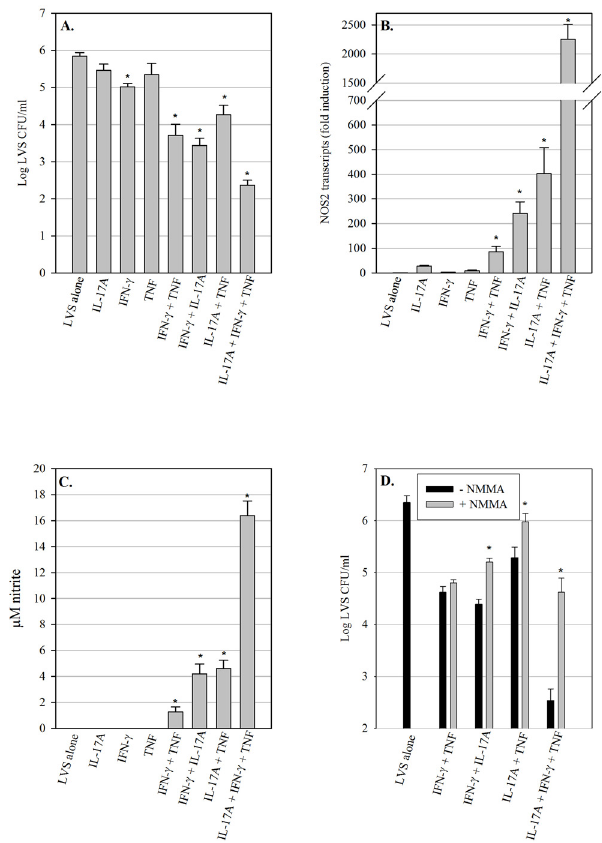
Fig 1. Cytokine-induced control of F . tularensis LVS growth in pulmonary epithelial cells is partially dependent upon RNI. (A) TC-1 lung epithelial cells were infected with LVS, and intracellular bacteria were enumerated after 72 h. Cultures were treated with recombinant cytokines immediately after infection as indicated, or untreated ( ‘ LVS alone ’ ). * = significantly different from ‘ LVS alone ’ cultures (P < 0.05). (B) Changes in expression of NOS2 in TC-1 cell cultures infected with LVS and treated with recombinant cytokines. Fold induction values are expressed relative to ‘ LVS alone ’ cultures. * = significantly different from cultures treated only with single cytokines (P < 0.05). (C) Nitrite production in TC-1 cell cultures infected with LVS and treated with recombinant cytokines after 72 h. * = significantly different from ‘ LVS alone ’ cultures (P < 0.05). (D) 72 h growth of LVS in cytokine-treated TC-1 cultures in the presence of NMMA. * = significantly different from LVS growth in identically treated cultures in the absence of NMMA (P < 0.05). Data are expressed as the mean ± SD of triplicate cultures, and plots are representative of three experiments of similar